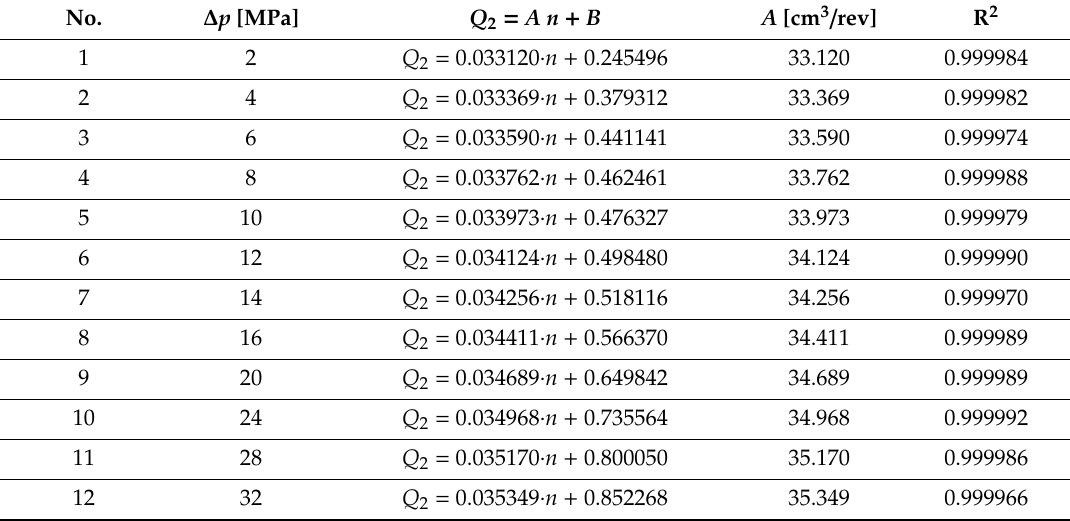
Table A1. Equations Q 2 = A · n + B of motor output flow rate at ∆ p = const. (Toet’s method).